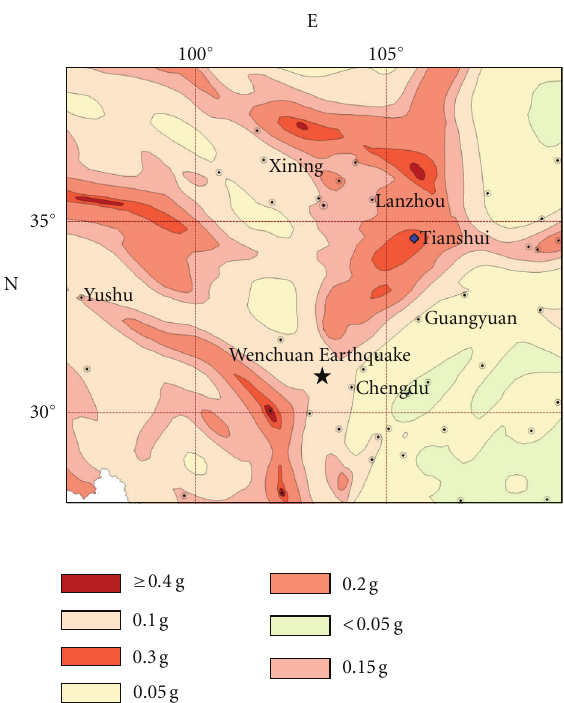
Figure 3: Chinese national design peak ground acceleration with 10 percent probability of exceedance in 50years